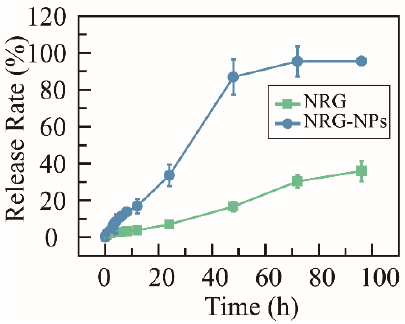
Figure 3. Time-dependent cumulative release profile of NRG NPs and NRG powder at 37 °C, n = 3.